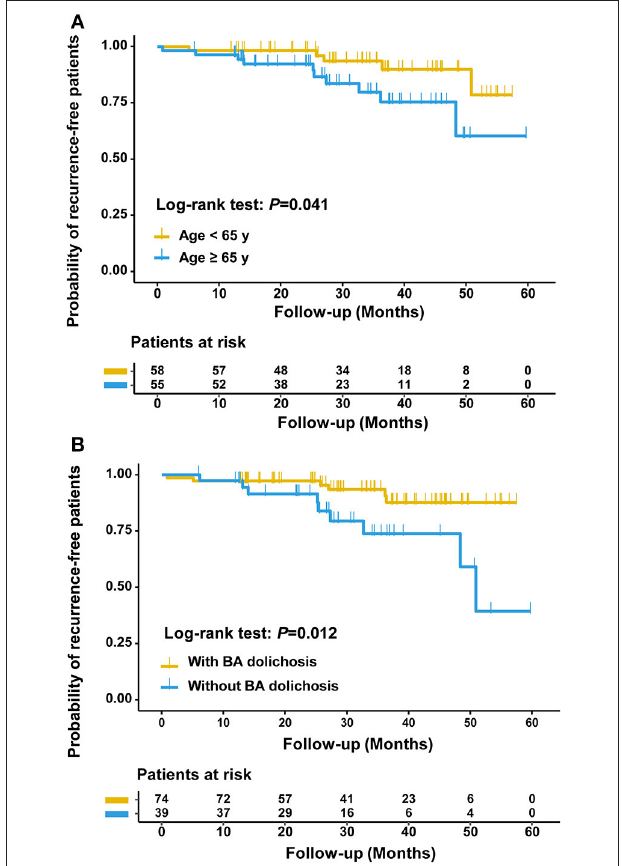
FIGURE 3 | Kaplan-Meier curves estimating the probability of being recurrence-free between patients aged ≥ 65 years and aged < 65 years (A) and between patients with and without BA dolichosis (B) .